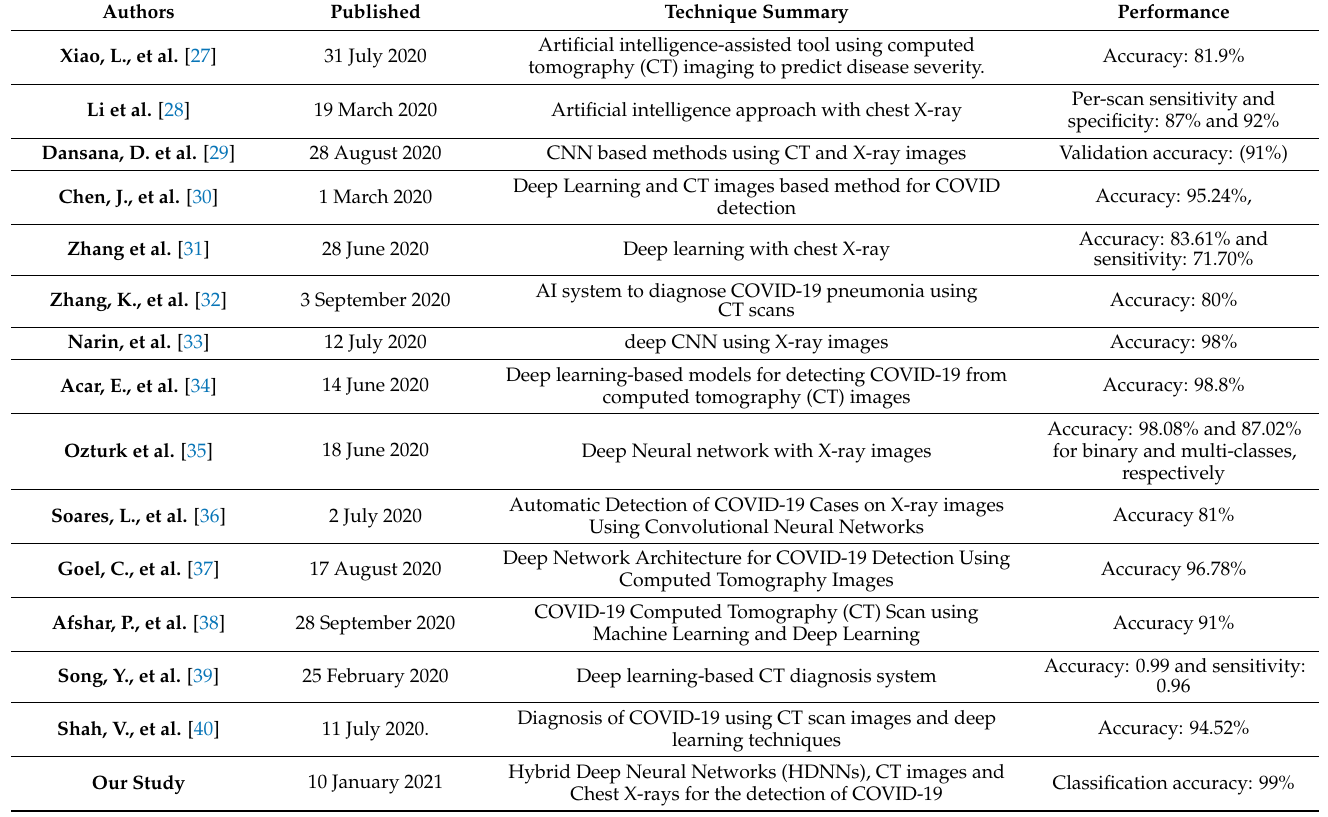
Table 1. Performance comparison of existing COVID-19 detection techniques with HDDNs, in which the shaded area represents the chest X-rays-based techniques that are used as a benchmark for this